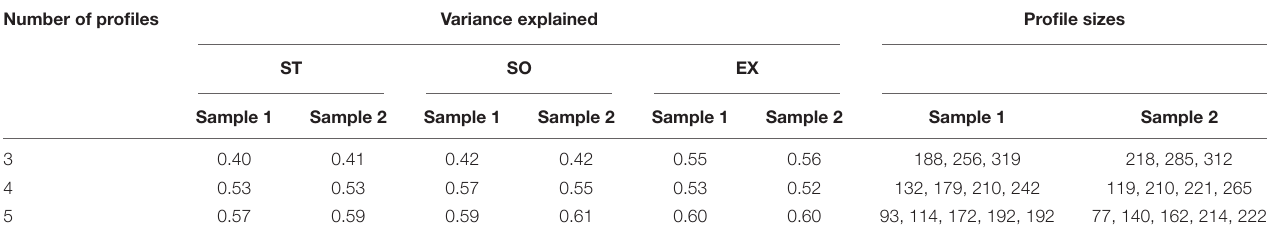
TABLE 3 | Indices for k -means profile solutions. Number of